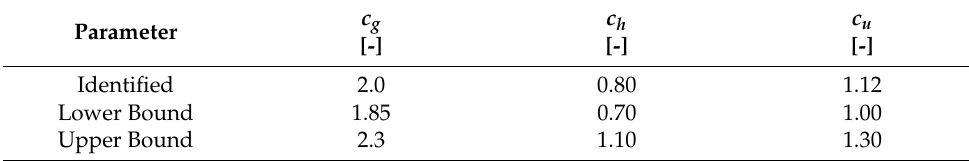
Table 8. Identified model parameters and search space for the Kikuchi Element.